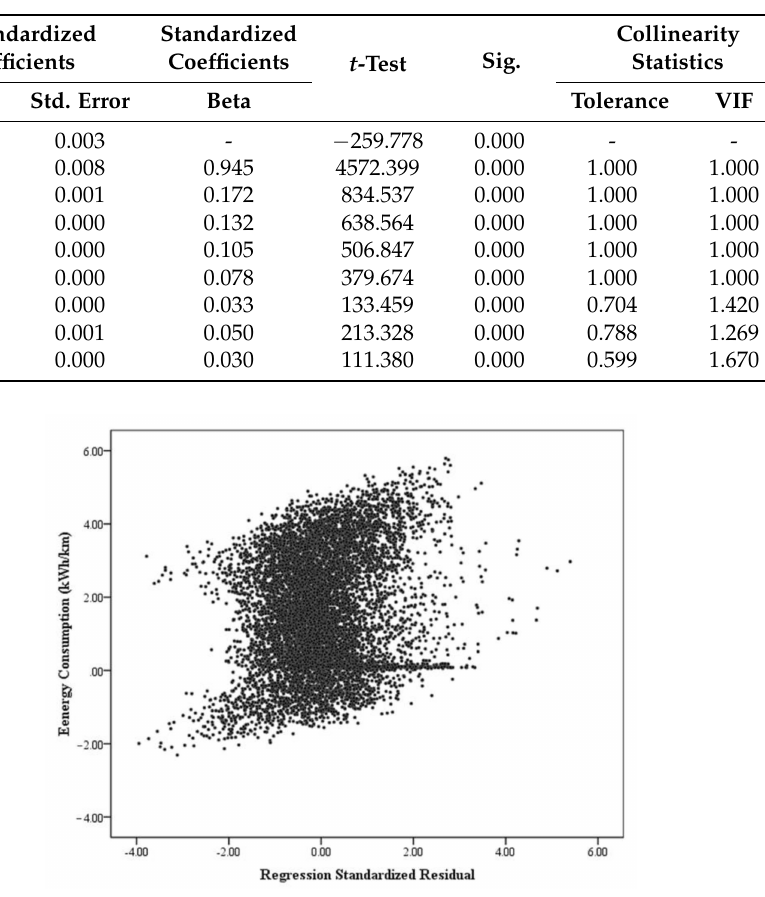
Table 7. Results of the energy consumption regression model.